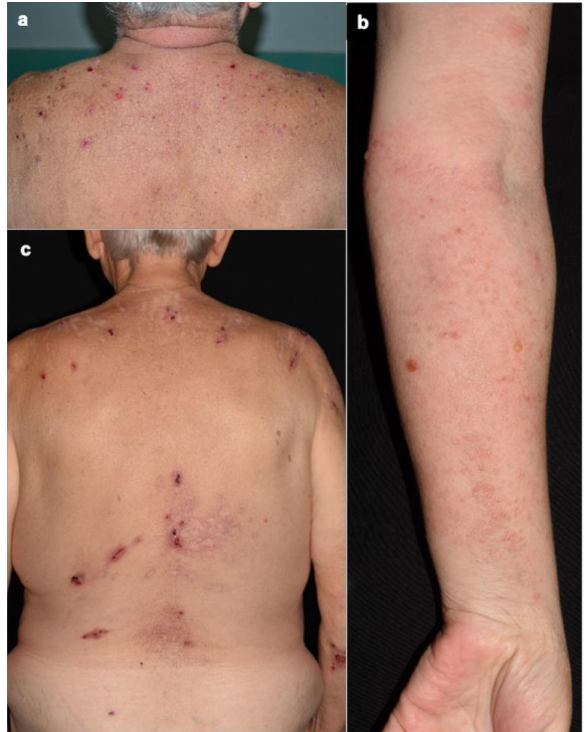
Figure 1. ( a ) Mild skin involvement localized to the upper part of the trunk with small, round erosions without erythema in a DPP4i-BP patient. ( b ) Small, herpetiform blisters with mild erythema on the forearm in a DPP4i patient. ( c ) Similar clinical lesions with hypo-, and hyperpigmentation and linear